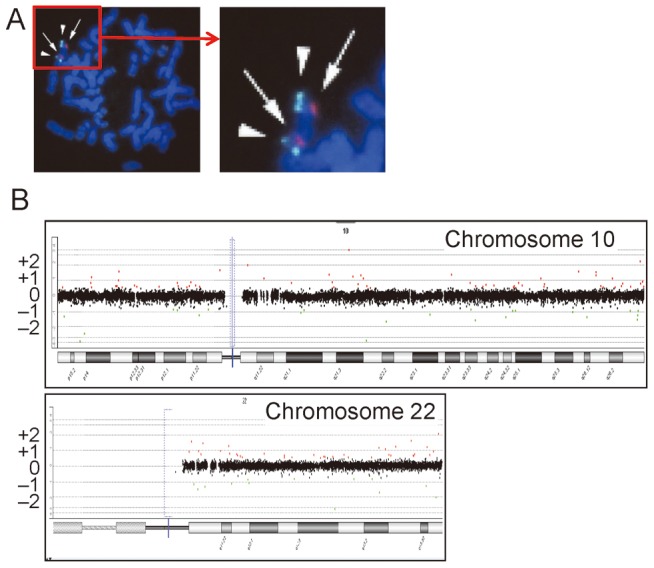
FISH and array CGH analyses in the proband (III-5).
A. FISH analysis. Two signals are shown for both HIRA at 22q11.2 (red signals indicated by arrows) and ARSA at 22q13 (green signals indicated by arrowheads). B. Array CGH analysis. No copy number change is found for chromosome 10 carrying the second DiGeorge region and chromosome 22 harboring the DGS/VCFS critical region, as well as other chromosomes (not shown). Black, red, and green dots denote signals indicative of the normal, the increased (>+0.5), and the decreased (<−0.8) copy numbers, respectively. Although several red and green signals are seen, there is no portion associated with ≥3 consecutive red or green signals.